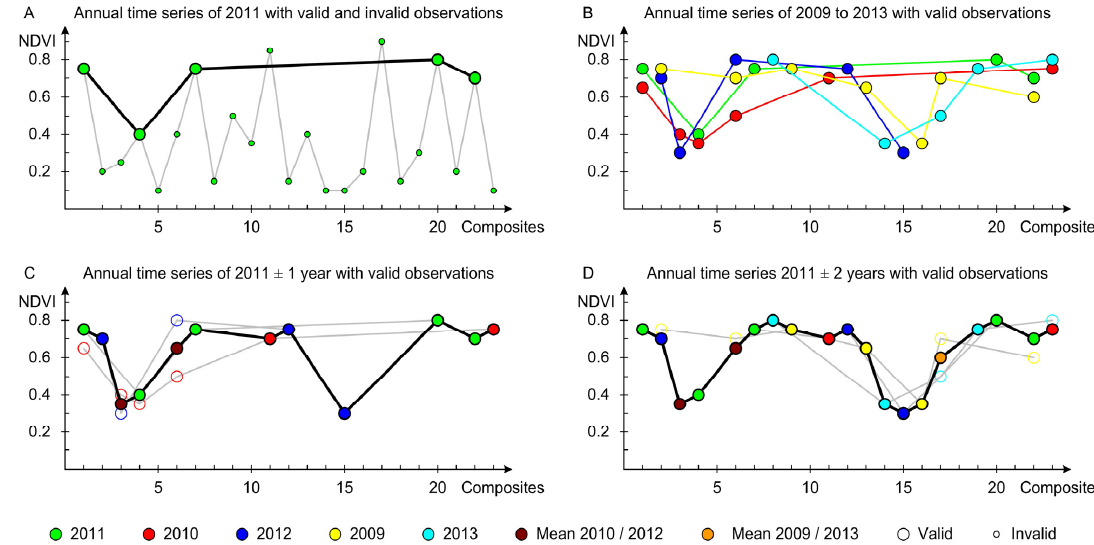
Figure 1. Multi-year data integration for time series generation. The hypothetical data should represent an annual time series with bi-modal characteristics, typical for agriculture with two growing seasons. ( A ) Time series of 2011 of valid (large circles) and invalid (small circles) observations connected by a grey line and linear temporal interpolation of valid data shown by a black line; ( B ) annual time series from valid observations of five years in different colors; ( C ) integrated time series from data of 2011 ± 1 year; and ( D ) integrated time series from 2011 ± 2 years, based on (C). Void circles and grey lines in (C) and (D) indicate valid data and linear interpolation of annual data from (B).